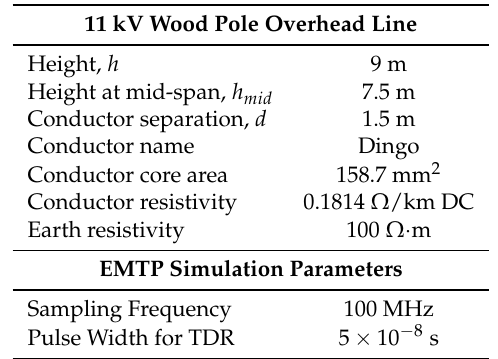
Table 1. Characteristics of the OHTL and Simulation